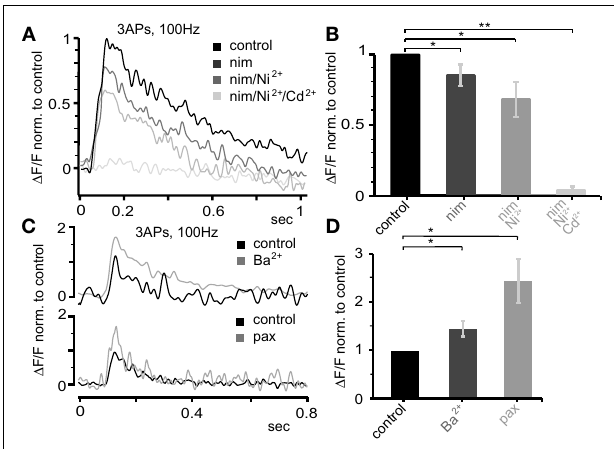
FIGURE 8 | Dendritic electrogenesis is regulated by Ca 2 + and K + channels. (A) Effect of the following Ca 2 + channel blockers on Ca 2 + signals ( Δ F/F) evoked by trains of three APs at 100 Hz at the apical dendrite 425 µm from soma in a P25 neuron: nimodepine (nim, 10 µM, L-type), Ni 2 + (100 µM, T-/R-type), and Cd 2 + (500 µM, all Ca 2 + channels). All traces were normalized to the control trace. (B) Group data for the effect of Ca 2 + channel blockers (normalized to control, mean ± sem, n = 5). (C) Effect of BK (1 µM paxilline) and A-type K + Ca (150 µM Ba 2 + ) channel blockers on the Ca 2 + signals produced by bursts of three APs at 100 Hz 300–400 µm from soma in the apical dendrite in P25 neurons. (D) Average data (mean ± sem) from nine similar experiments ( n = 5, Ba n = 4) normalized to control. All data are from P25 Pax